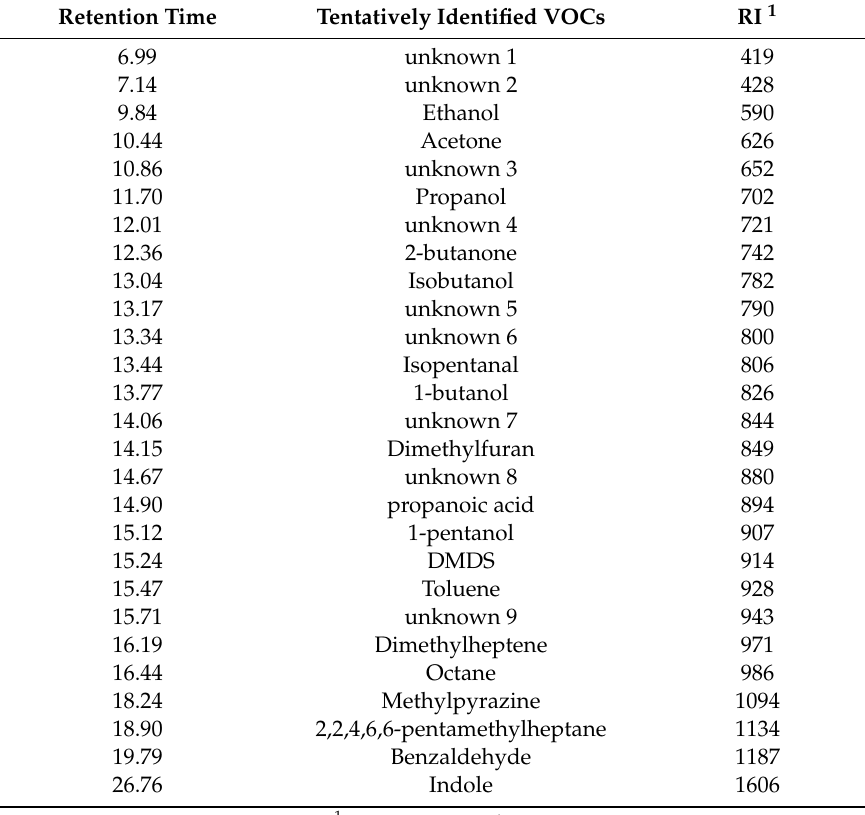
Figure 5. A representative chromatogram of E. coli bacterial culture, using the SPME fibre preconcentration method, and GC-MS. Table 1. List of the VOCs detected in the headspace above the E. coli culture at 300 min.